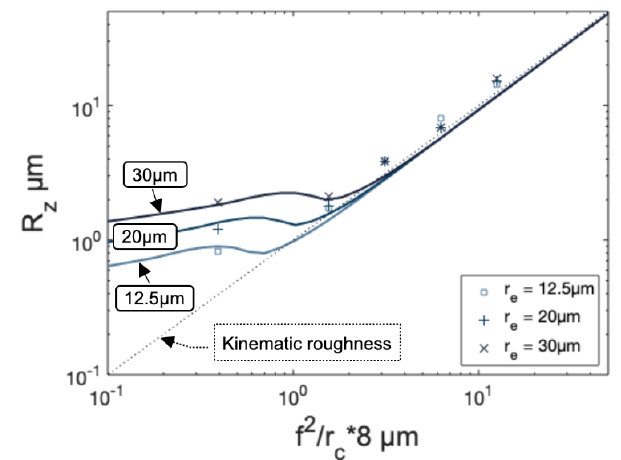
Figure 9. Roughness ( R z ) model (lines) compared to data gathered through experimental investigation in